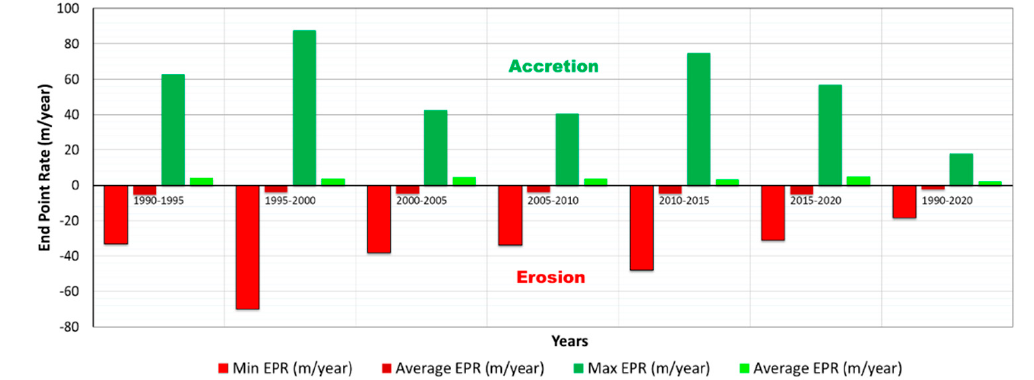
Remote Sens. 2023 , 15 , x FOR PEER REVIEW Figure 7. Coastal change rates from 1990 to 2020. Figure 7. Coastal change rates from 1990 to 2020.